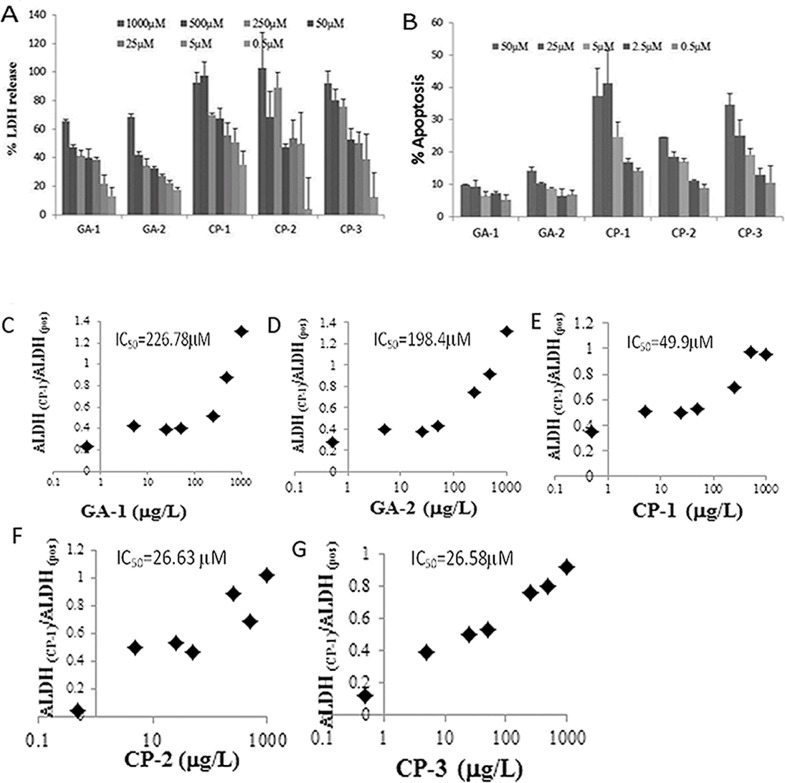
Effect of GA on lactate dehydrogenase (LDH) release: U373 MG astroglioma cells were exposed to increasing concentrations of indicated GILZ analog (GA) or control peptide (CP) (0.5μM to 1mM) for 24 h.The release of LDH into the cell culture supernatant from damaged cells was measured. % LDH was calculated as the ratio of the difference between the peptide treated and untreated cells to that of the difference between the positive control and the untreated cells (A). Data represent average +/- SD from three experiments. The IC50 was determined by logarithmic extrapolation (C-G). Flow cytometric analysis of Annexin positive U373 cells treated as indicated was determined as a measure of apoptosis (B).